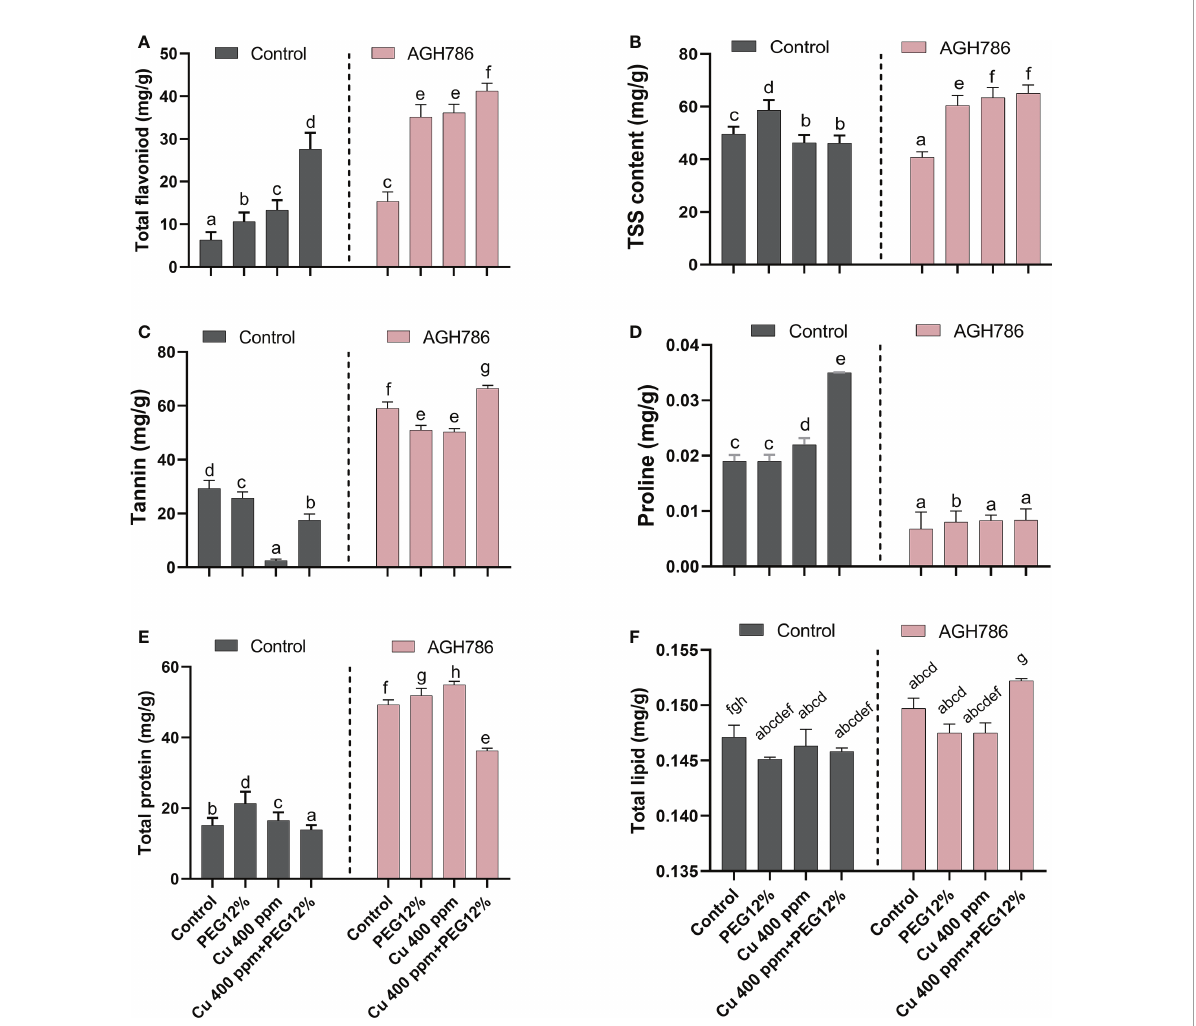
FIGURE 6 Effect of P. spadiceum AGH786 on metabolic attributes of S. lycopersicum L. under heavy metal (Cu) toxicity and drought stress (12% PEG). (A) Total fl avonoids, (B) total soluble sugar, (C) tannins, (D) proline, (E) total protein, and (F) total lipids. Data represent the mean with standard error, and letters represent the signi fi cant difference (p <